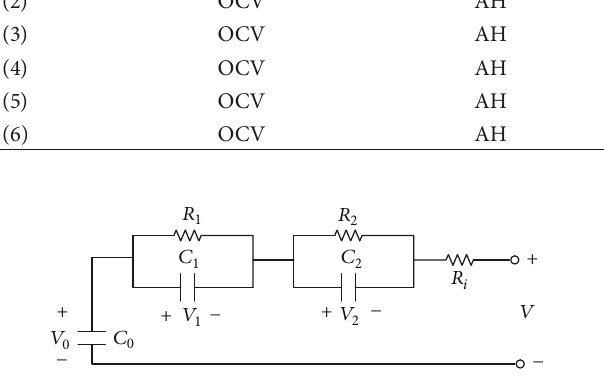
Figure 3: Second-order RC circuit battery